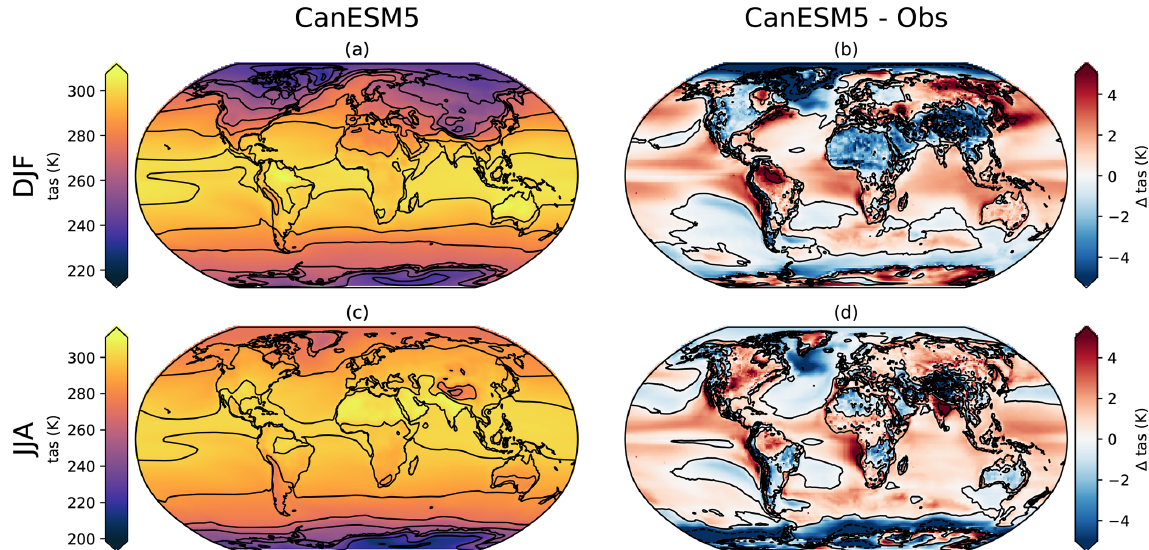
Figure 5. Climatologies of surface air temperature over 1981 to 2010 in CanESM5 (a, c) and their bias from ERA5 over the same period (b, d) shown for the DJF (a, b) and JJA (c, d) seasons.